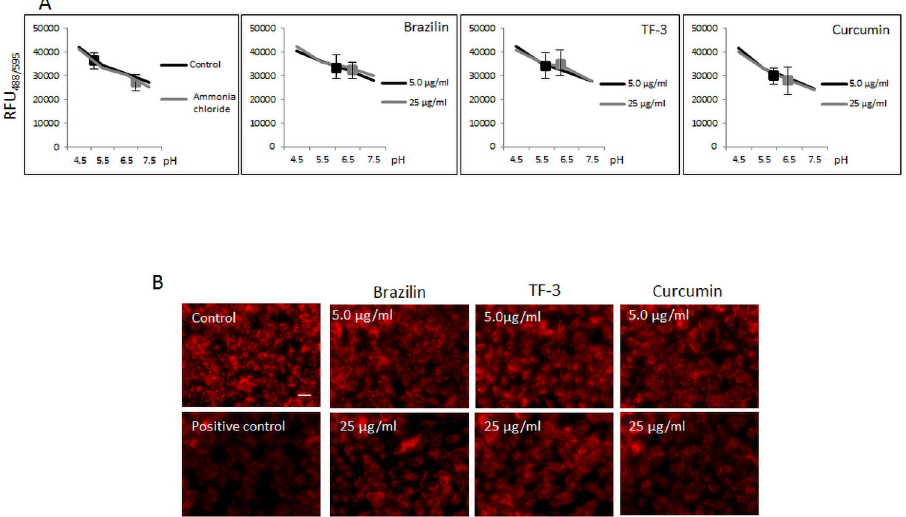
Fig 7. Effect of selected polyphenols on internal pH and endosome acidification. (A) Intracellular/lysosomal pH measurement. pHrodo ™ Green AM dye and additional incubation for 30 min. at 37˚C. Cells were then washed and fluorescence was measured at Ex/Em = 535/595 nm. Intracellular pH identification was done using standard curve prepared by measuring fluorescence in the presence of standard buffers with indicated pH as described in Material and Methods section. (B) Endosomal pH measurement in A549 cells treated with indicated polyphenols at different concentrations for 3h at 37˚C. Scale bar indicates 50 μ m. Images are representative of all observed fields. Experiments were done in triplicates and repeated three times. Data are presented as % of control ± SD. TF-3 –theaflavin-3,3’- digallate; control– 0.025% DMSO, positive control– 20 mM ammonia chloride.